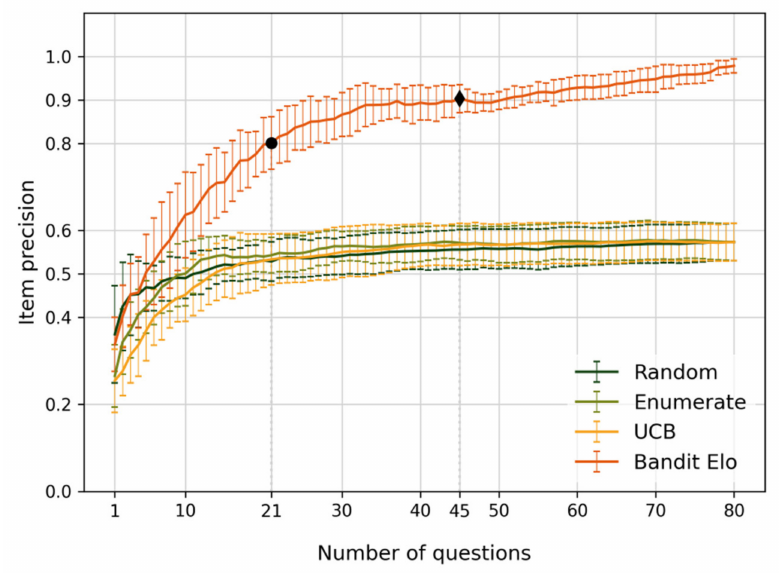
Figure 4. Formative assessment precision selecting items as a function of quiz length for synthetic students. Simulated data from 10 groups, taking 10 different quizzes, 120 students in each